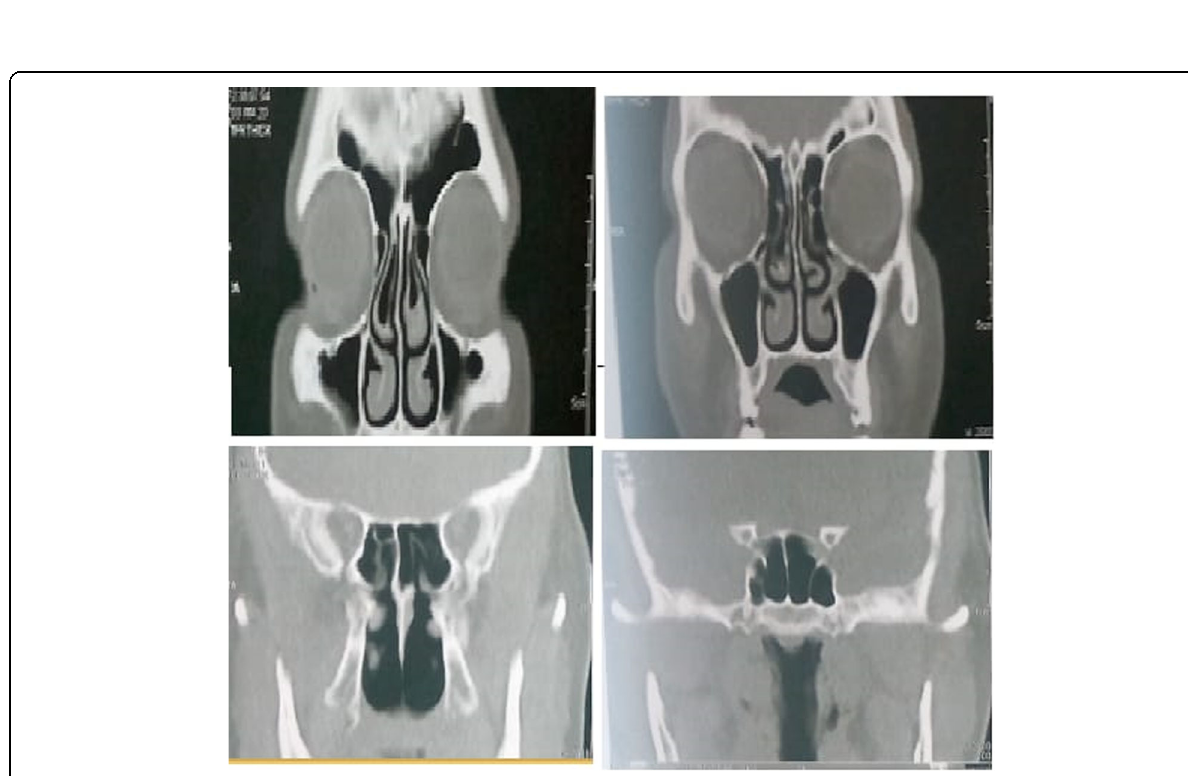
Fig. 8 CT PNS of the same patient after receiving oral steroid, showing complete